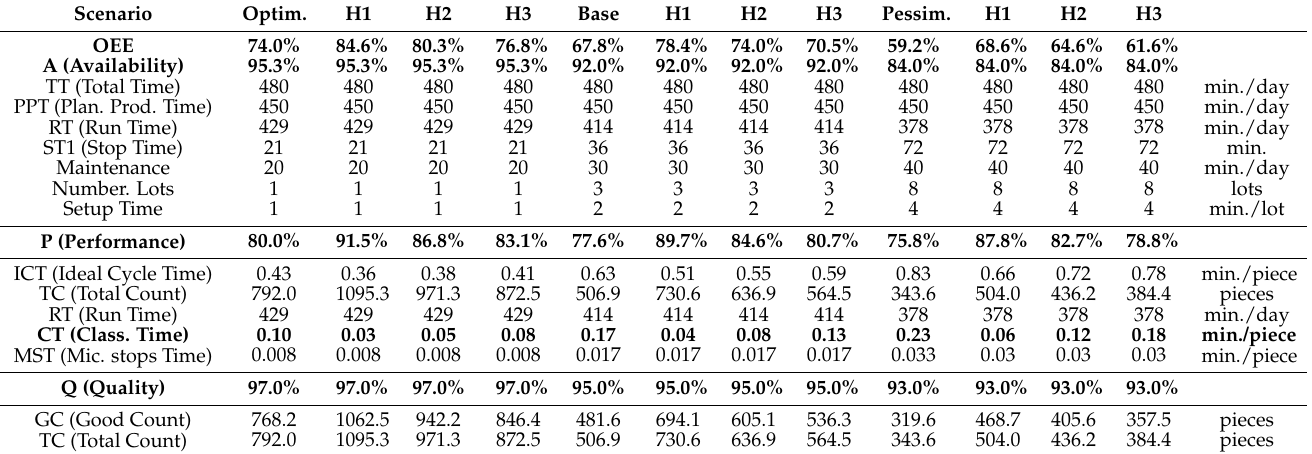
Table 3. Calculation of OEE in pilot machine because of factory connectivity implementation.